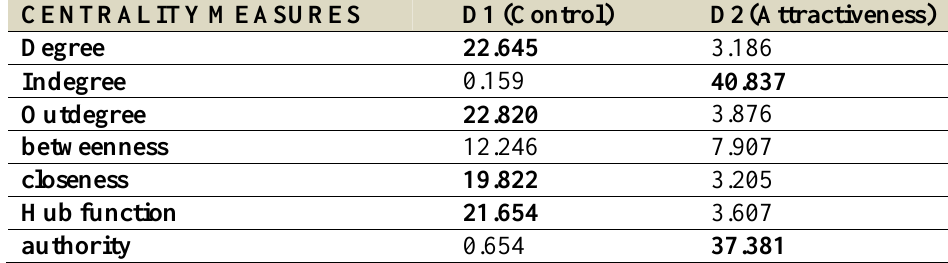
Table 2. Contribution of centrality measures to the dimensions of the